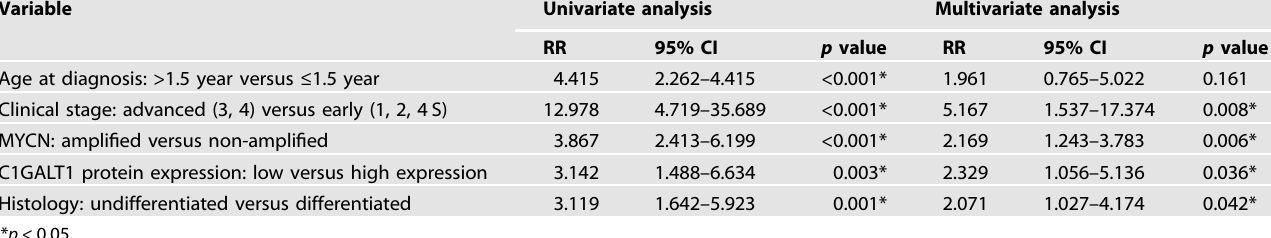
Table 2. Clinicopathologic and biologic factors affecting survival rate in NB